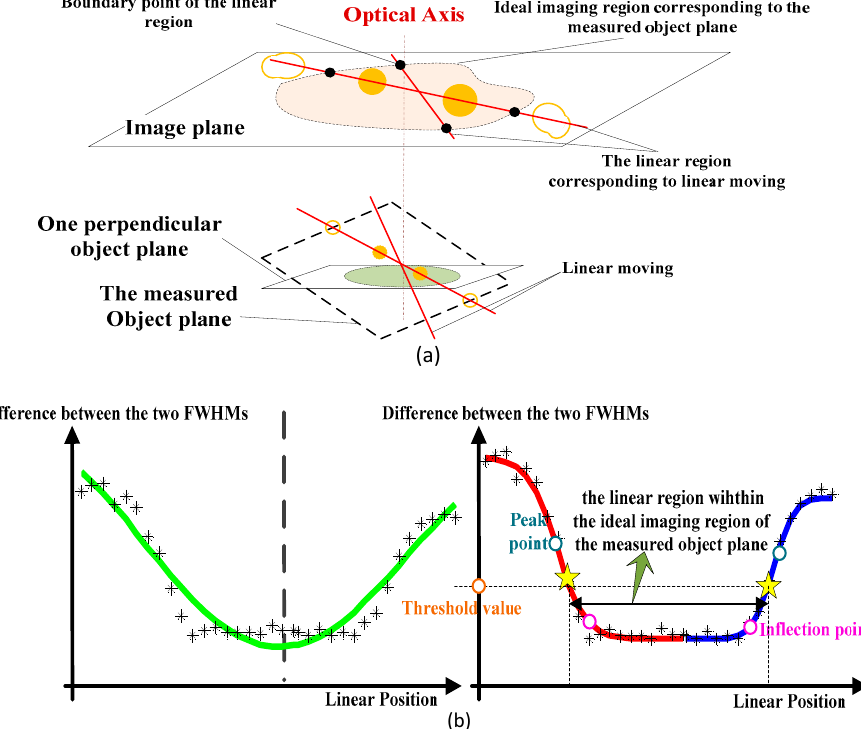
Figure 6. ( a ) Imaging of a nanoparticle moving on the measured object plane; ( b ) polynomial combining the logistic curve fitting method to judge the ideal imaging region of the measured object plane.